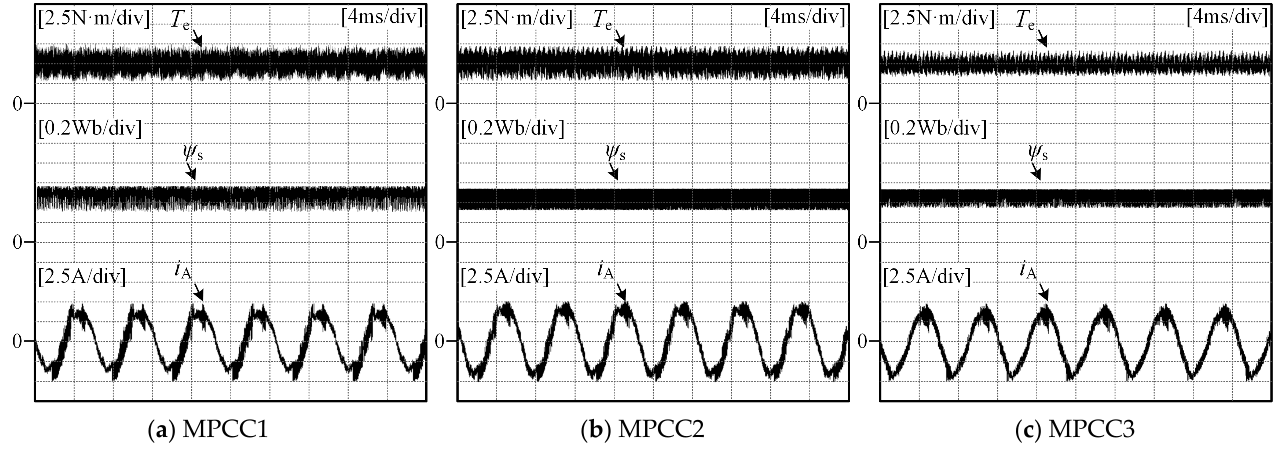
Figure 9. Experimental results of MPCC1, MPCC2 and MPCC3 (case 1).